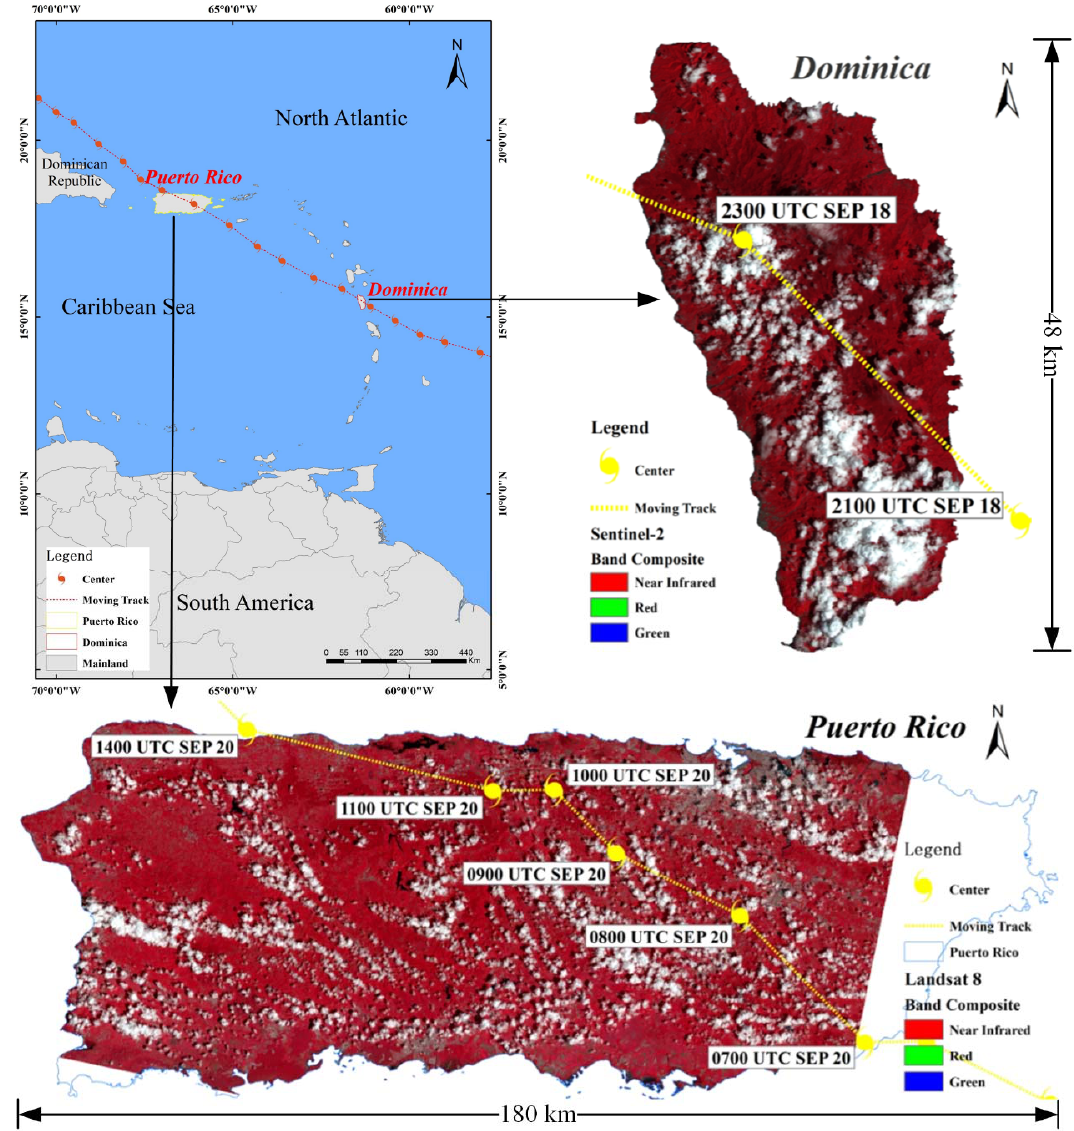
Figure 1. The moving track of Hurricane Maria and the location of Dominica and Puerto Rico.